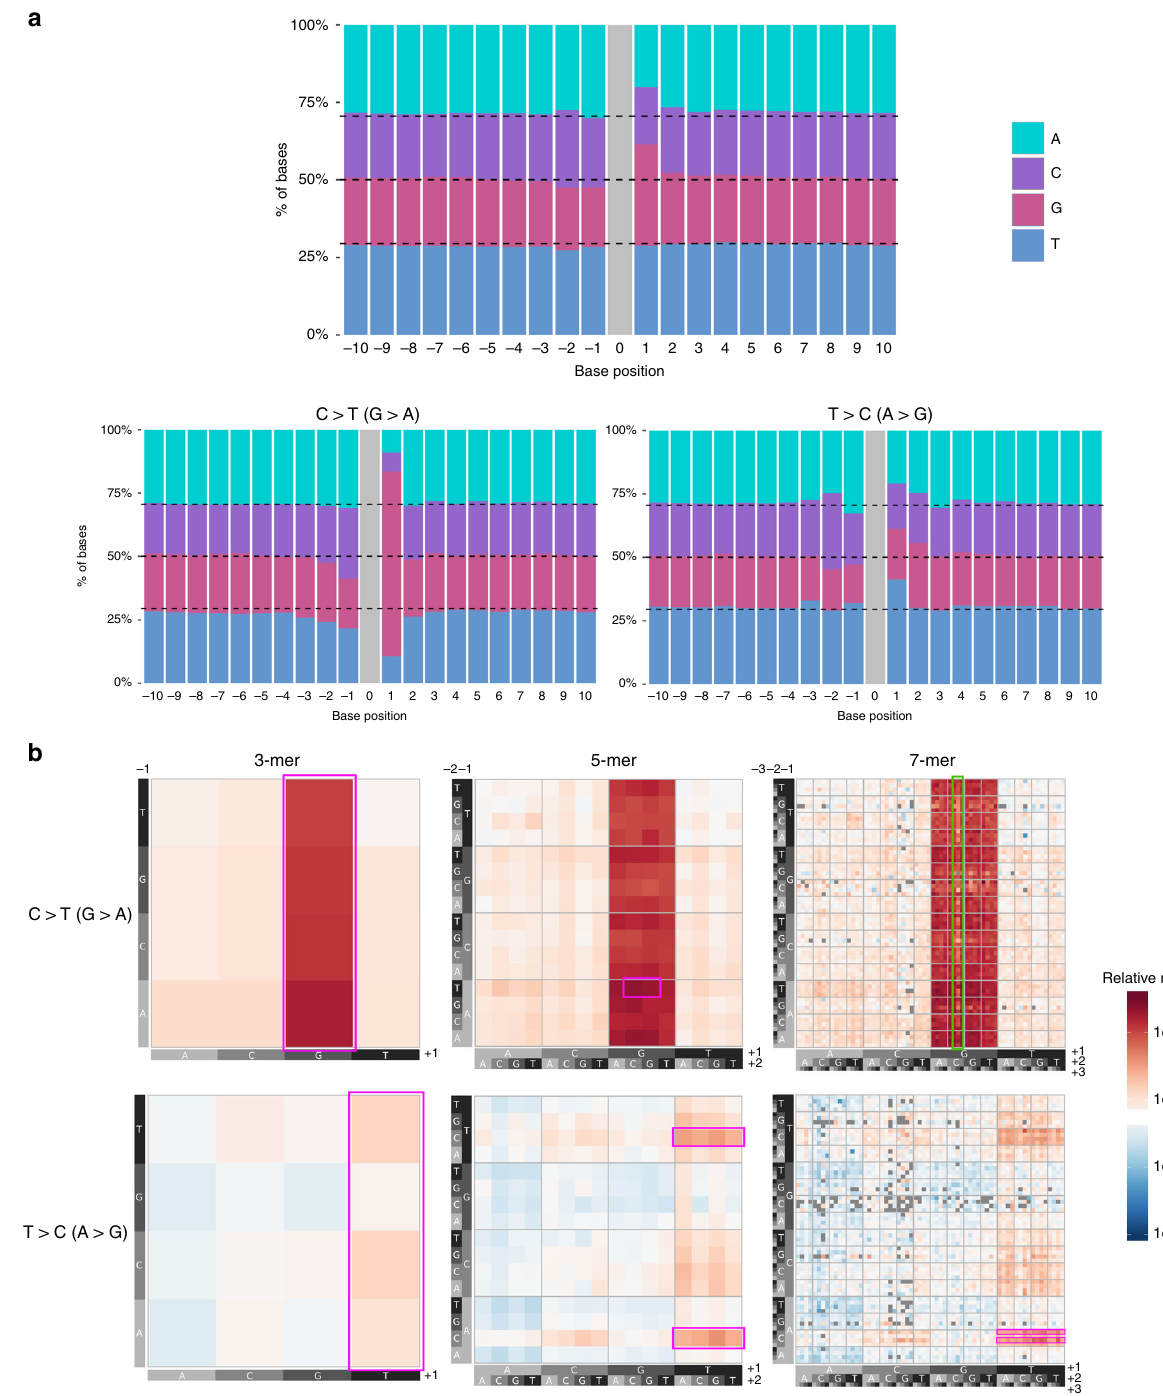
Fig. 3 Mutational classes with highest sequence context dependency around de novo mutations. a Frequencies of nucleotides neighboring our entire set of 679,547 DNMs and subsets belonging to C > T (G > A) and T > C (A > G) 1-mer classes in a window of size 21 bp. Black dashed lines represent the whole-genome background frequencies for the four nucleotides. The extended sequence context dependency varies across 1-mer mutation classes. b Heatmap of estimated relative mutation rates, corrected by abundance of reference k-mer, for C > T (G > A) (top) and T > C (A > G) (bottom) 1-mer classes, up to a 7-mer resolution. For each 1-mer class, each of the three grids delineates mutation contexts of different length, de fi ned by the upstream sequence ( y -axis) and downstream sequence ( x -axis) from the central (mutated) nucleotide. Boxed regions indicate motifs previously identi fi ed as hypermutable (pink) or hypomutable (green). Supplementary Figs. 4 and 5 show the corresponding plots for the other 1-mer